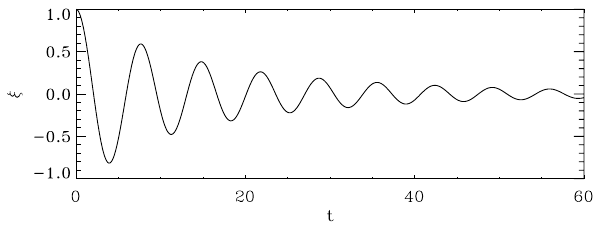
Fig. 8. Oscillations induced by the fixed source localized to the center of the current sheet.